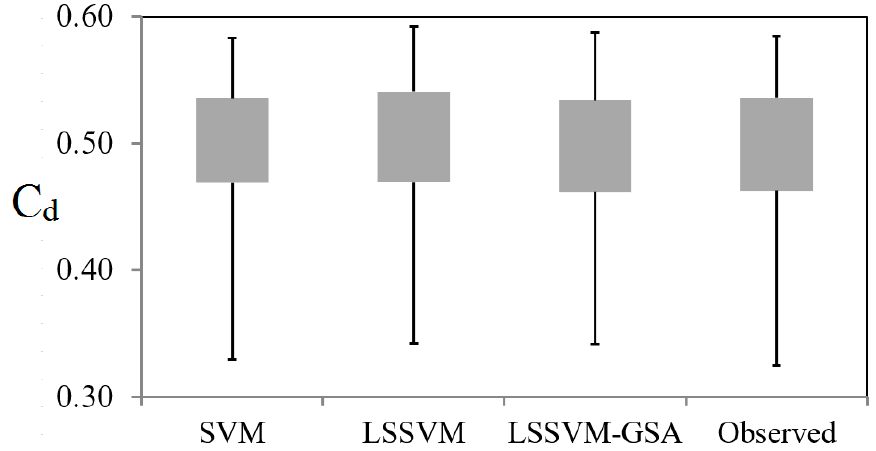
Figure 7. Boxplots of observed C d compared with predicted C d from SVM, LSSVM and LSSVM − GSA models.